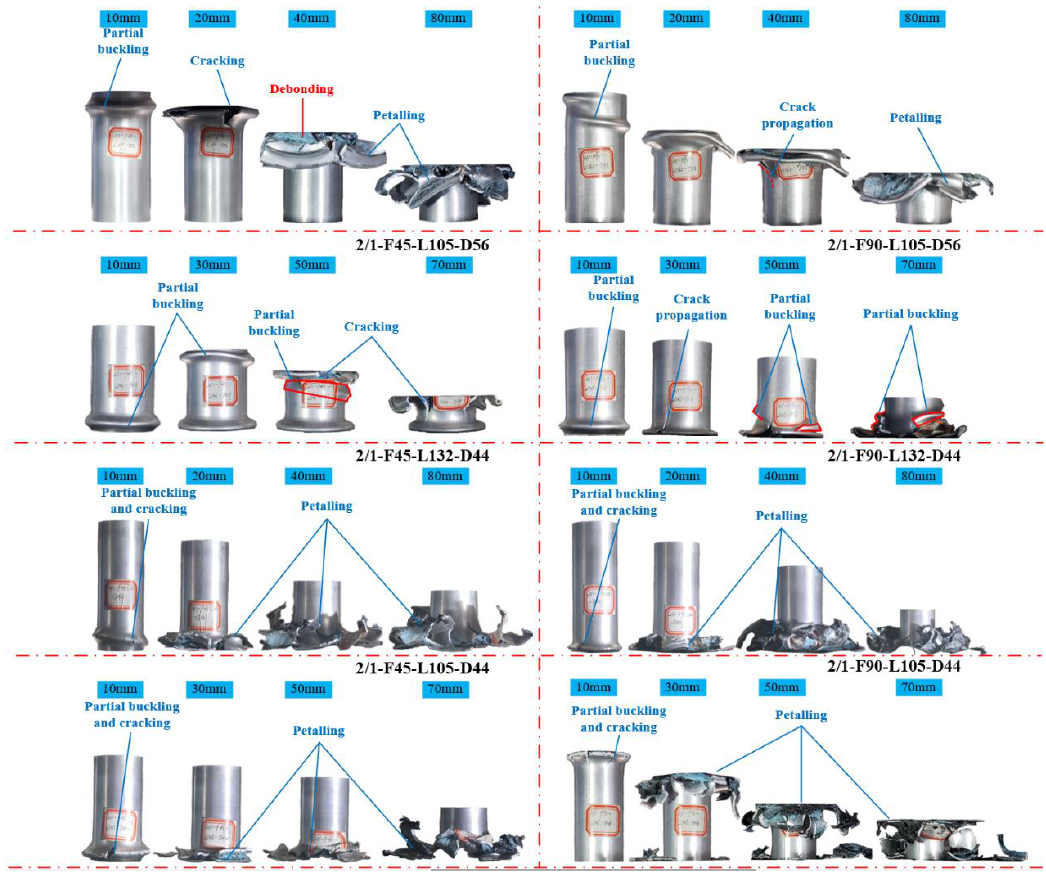
Figure 11. Axial crushing deformation process of 2/1 hybrid